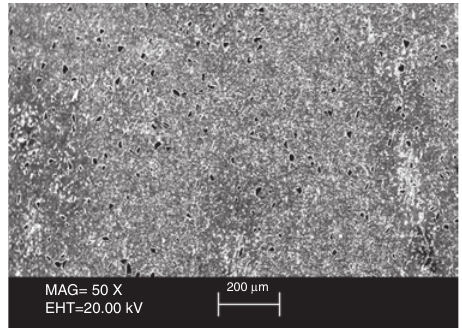
Figure 7 SEM microstructure image of the N2 sample.